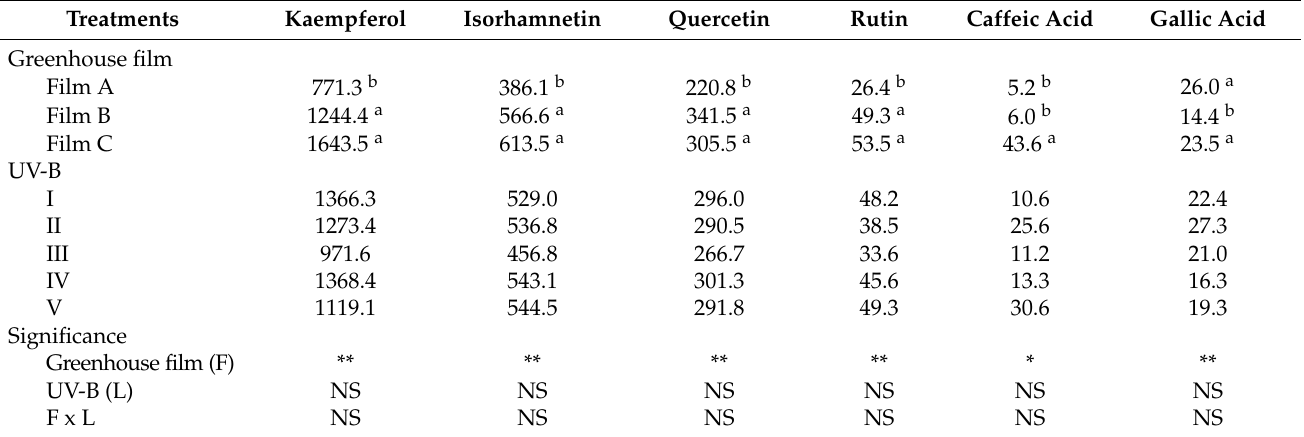
Figure 5. Total phenolic content (mg gallic acid equivalent GAE/100 g of dry weight D.W.) in wild rocket leaves as affected by interaction between greenhouse cover film (Film A: diffused light film; Film B: clear film; Film C: diffused light film with UV-B window) and UV-B applications (I: not treated with UV-B; II: treated with UV-B for 45 s; III: treated with UV-B for 150 s; IV: treated with UV-B for 330 s; V: treated with UV-B for 660 s). Vertical bars indicate standard error; different letters indicate significant differences according to Tukey’s test ( p ≤ 0.05). Table 1. Phenolic compound content (mg/100 g D.W.) in wild rocket leaves as affected by the main effect of greenhouse cover film (Film A: diffuse light film; Film B: clear film; Film C: diffused light film with UV-B window), and UV-B applications (I: not treated with UV-B; II: treated with UV-B for 45 s; III: treated with UV-B for 150 s; IV: treated with UV-B for 330 s; V: treated with UV-B for 660 s).